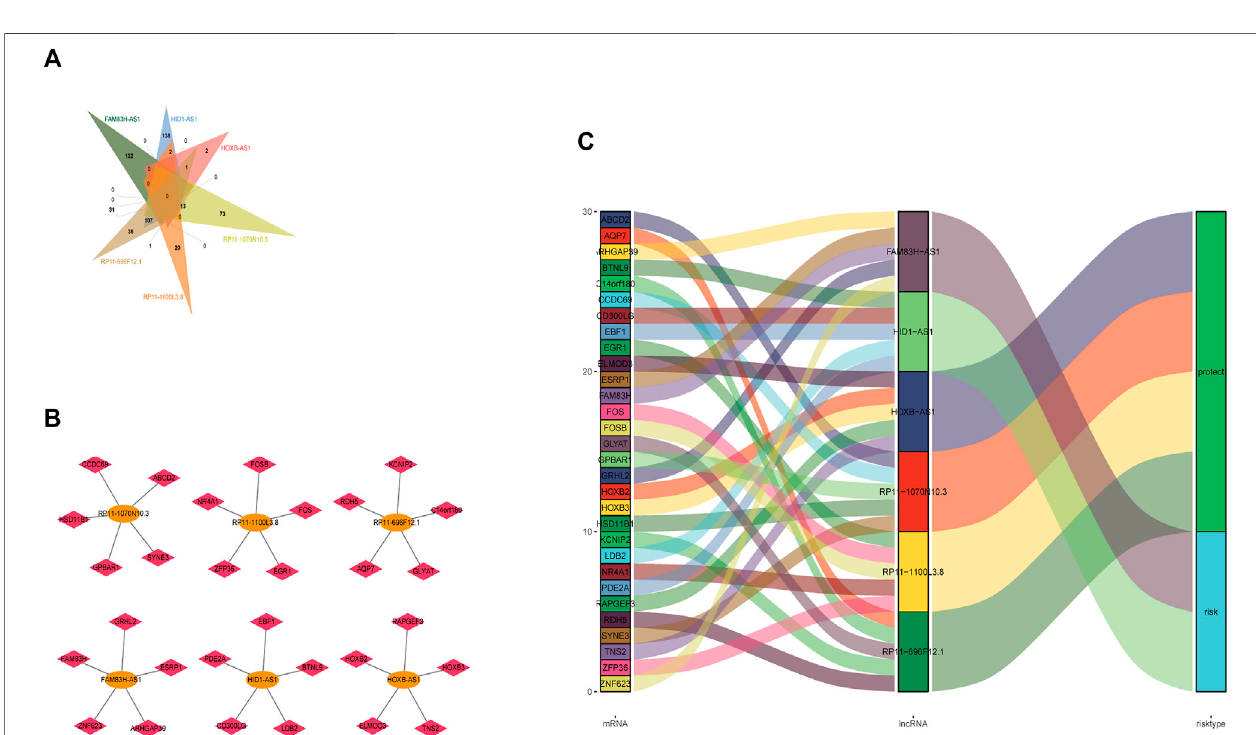
FIGURE 6| Potential regulatory mechanisms of lncRNAs in stemness-index-related lncRNAsignature. Venn diagram ofprotein-coding gene associated with all of six lncRNAs (A) , interaction network of fi ve most relevant protein-coding genes and each lncRNA (B) , and Sankey diagram showed fi ve most relevant protein-coding genes of each lncRNA (C) . KEGG pathway enrichment analysis of each lncRNA-related protein-coding gene. FAM83H-AS1 (D) , HID1-AS1 (E) , HOXB-AS1 (F) , RP11- 1070N10.3 (G) , RP11-1100L3.8 (H) , and RP11-696F12.1 (I) . KEGG, Kyoto Encyclopedia of Genes and Genomes.